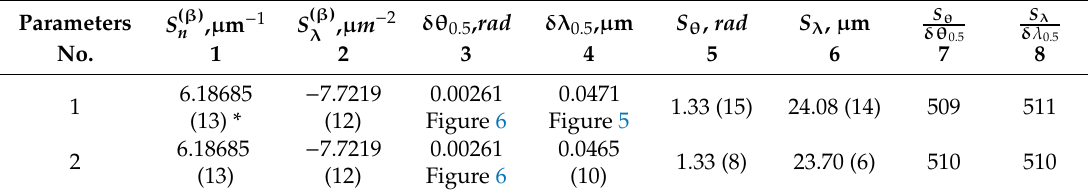
Table 1. Characteristic parameters of the waveguide ( S structure under the excitation of the surface plasmon–polariton